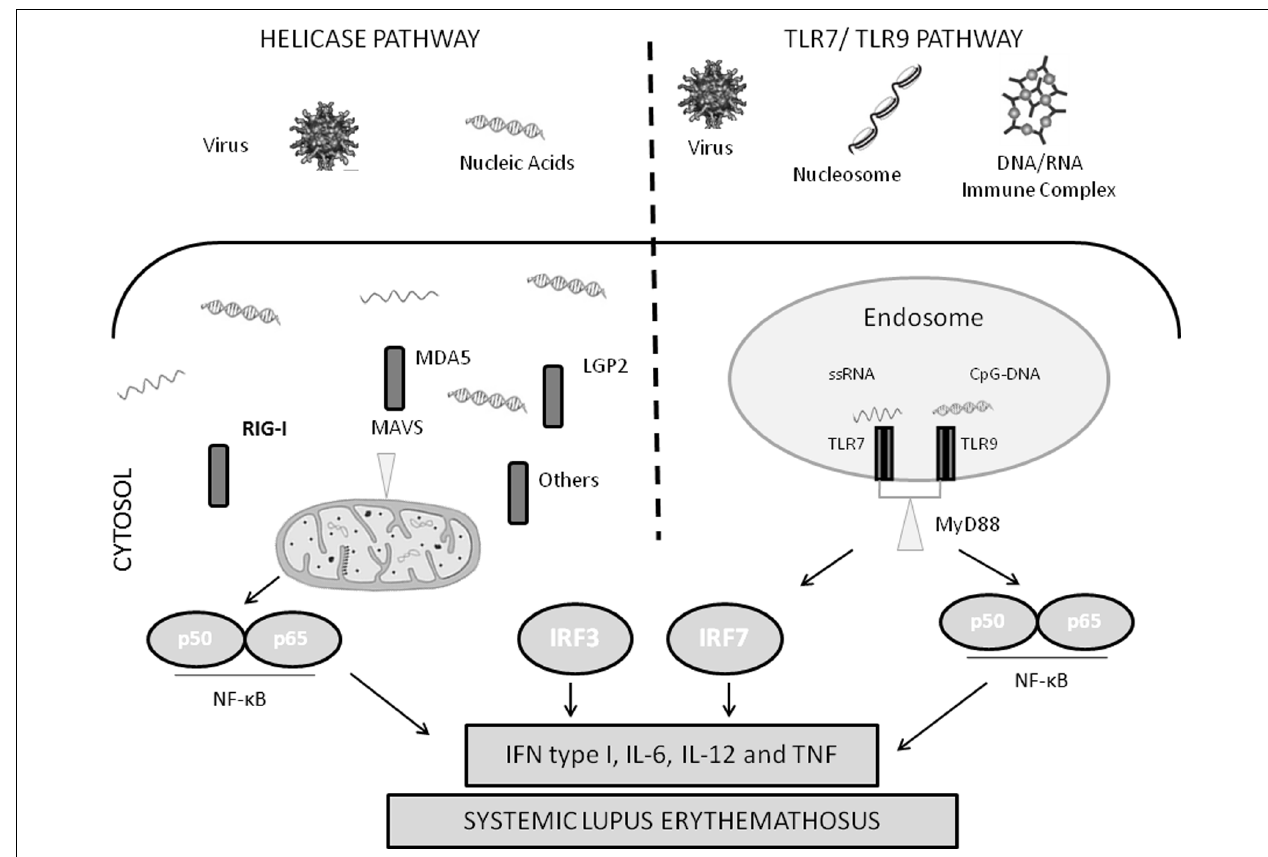
FIGURE 1 | Diagram of nucleic acid sensing antiviral immune response pathways. IFN, type I interferon; IL, interleukin; IRF, interferon regulatory factor; LGP2, laboratory of genetics and physiology 2; MAVS, mitochondrial antiviral signaling protein; MDA5, melanoma differentiation-associated gene